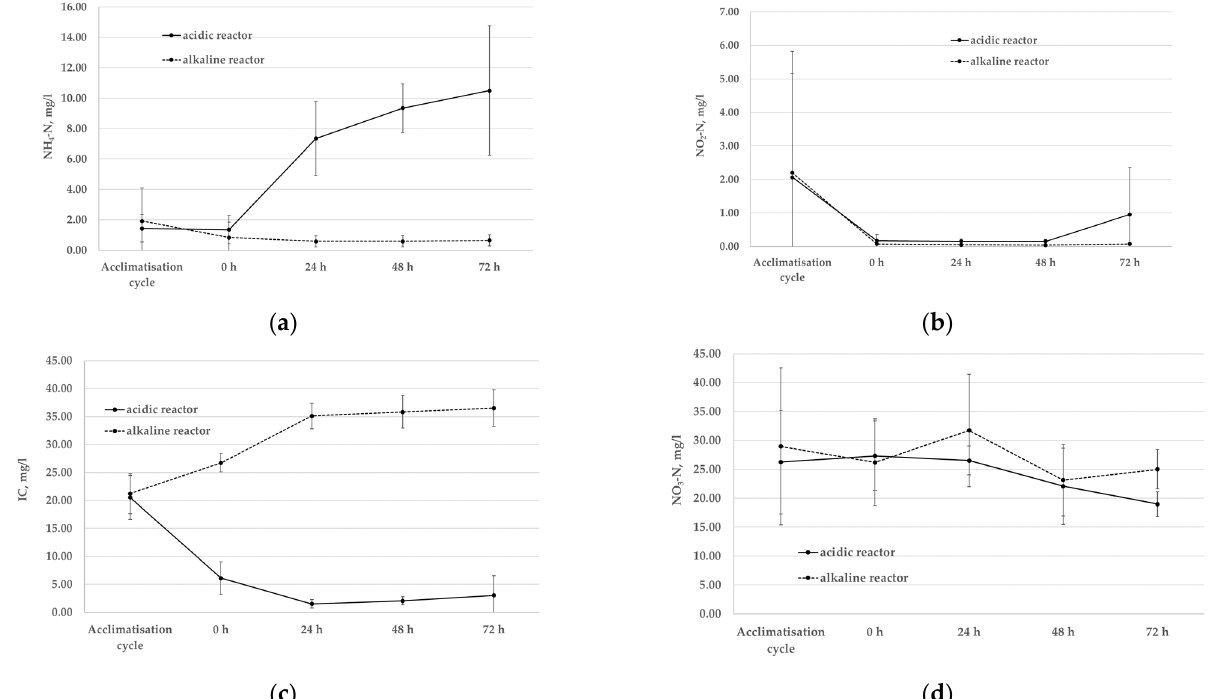
Figure 1. Changes of nitrogen and inorganic carbon compounds concentrations in acidic and alkaline pH reactors (n = 3): ( a ) NH 4 -N; ( b ) NO 2 -N; ( c ) IC; ( d ) NO 3 -N. Total phosphorus (TP) and PO 4 -P did not change significantly in both reactor efflu- ents from 0 h to 72 h after inhibitor addition (Tables S1 and S2).